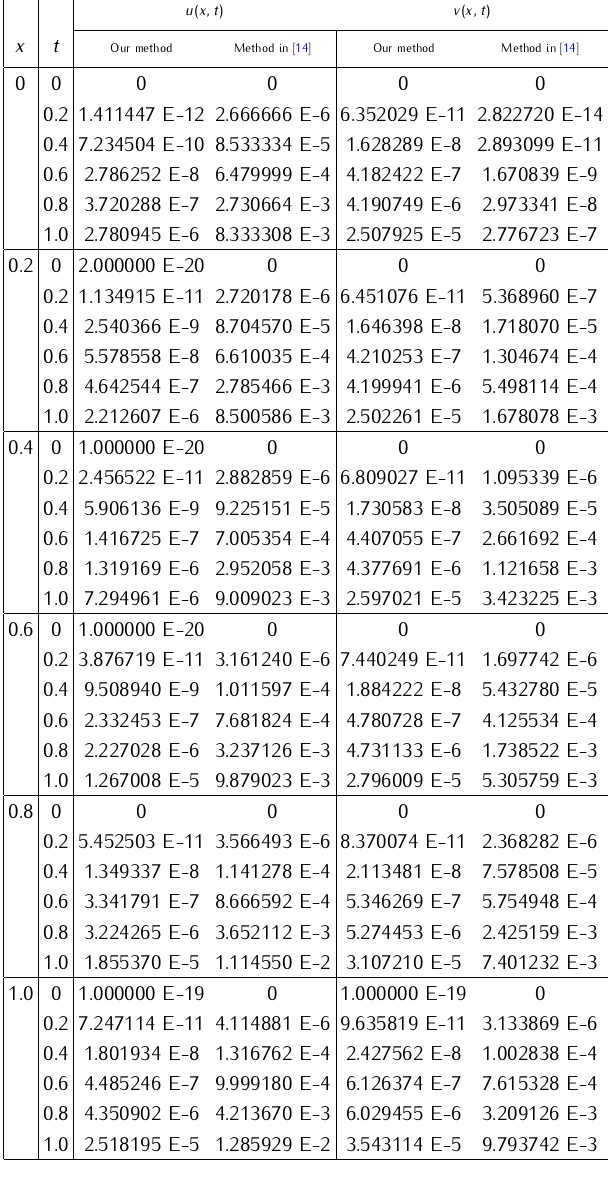
Table 1 : The absolute errors of our method in comparison to the method presented in